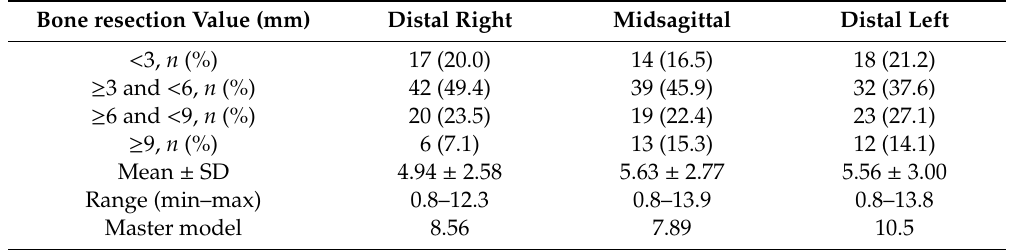
Table 3. Bone resection at each implant site for eligible patients and the master model.